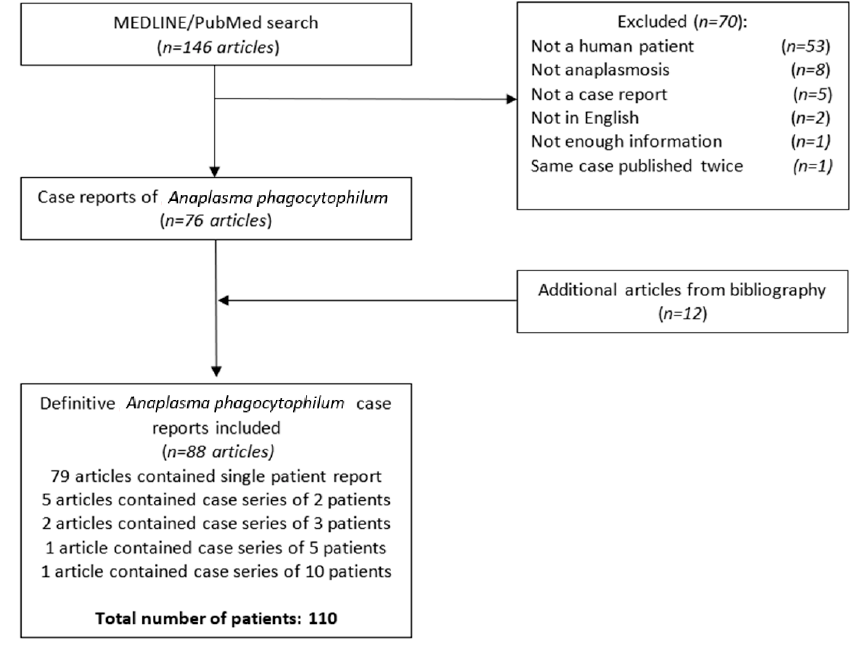
Figure 1. PRISMA flow chart.